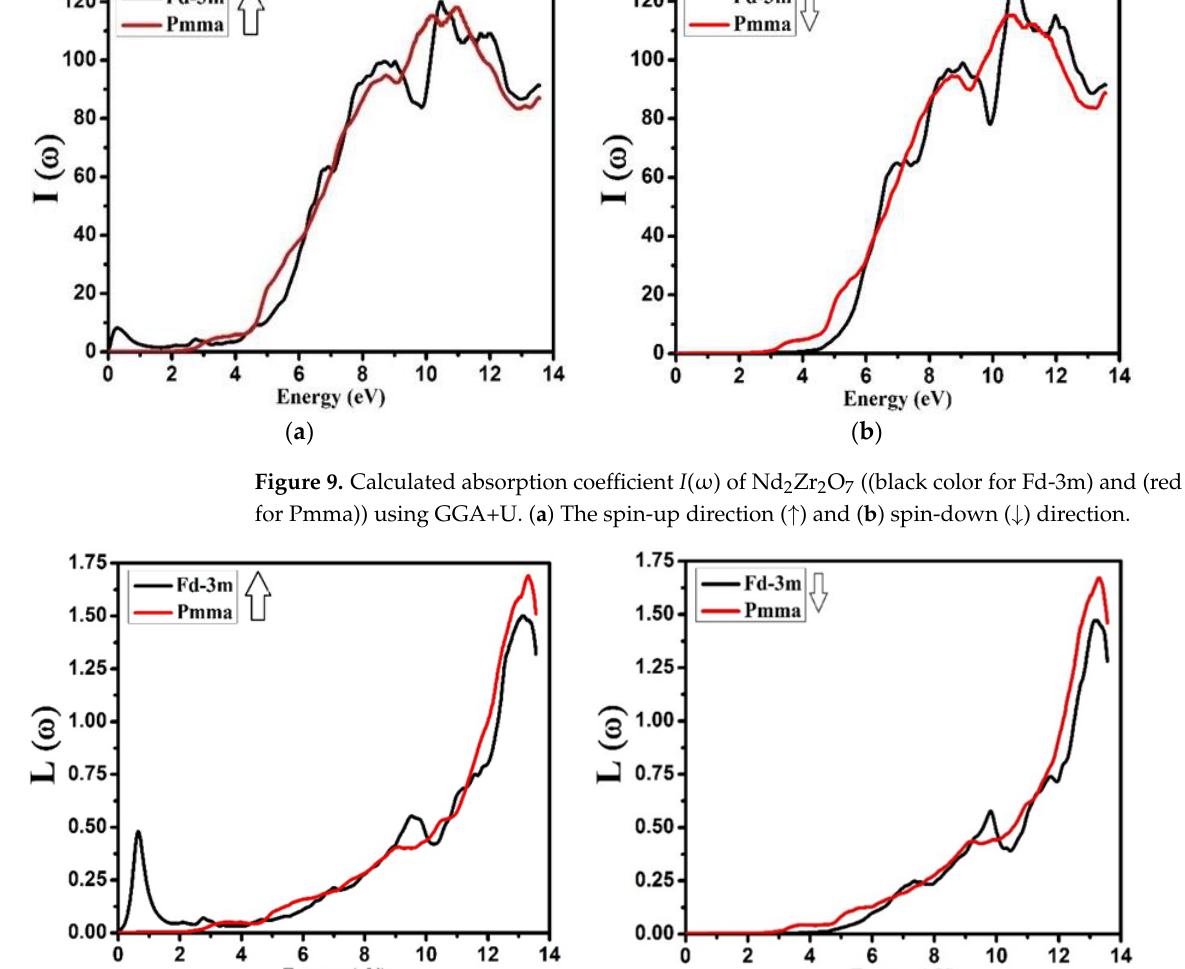
Figure 10. Calculated energy-loss function L ( ω ) for Nd 2 Zr 2 O 7 ((black color for Fd-3m) and (red color for Pmma)) using GGA+U. ( a ) The spin-up direction ( ↑ ) and ( b ) spin-down ( ↓ )